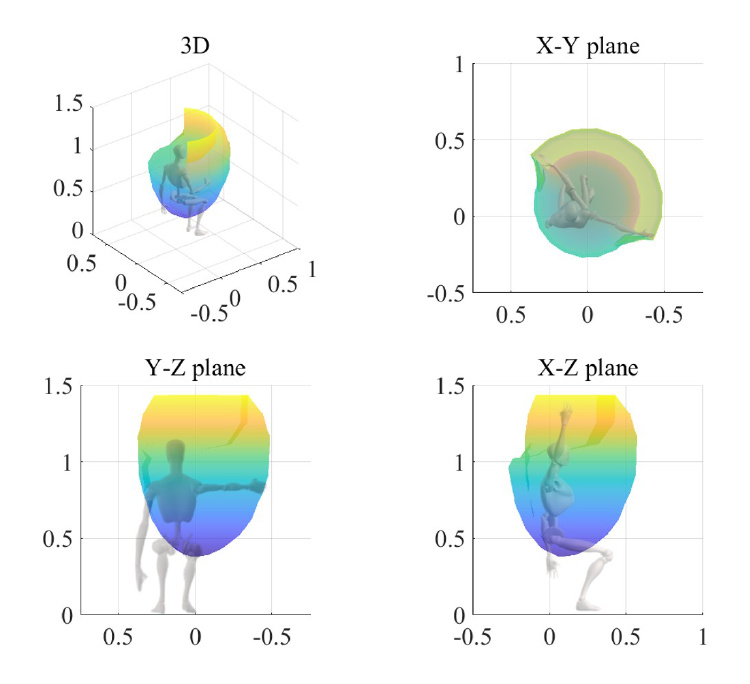
Figure 10. The workspace analysis of the K-handler.